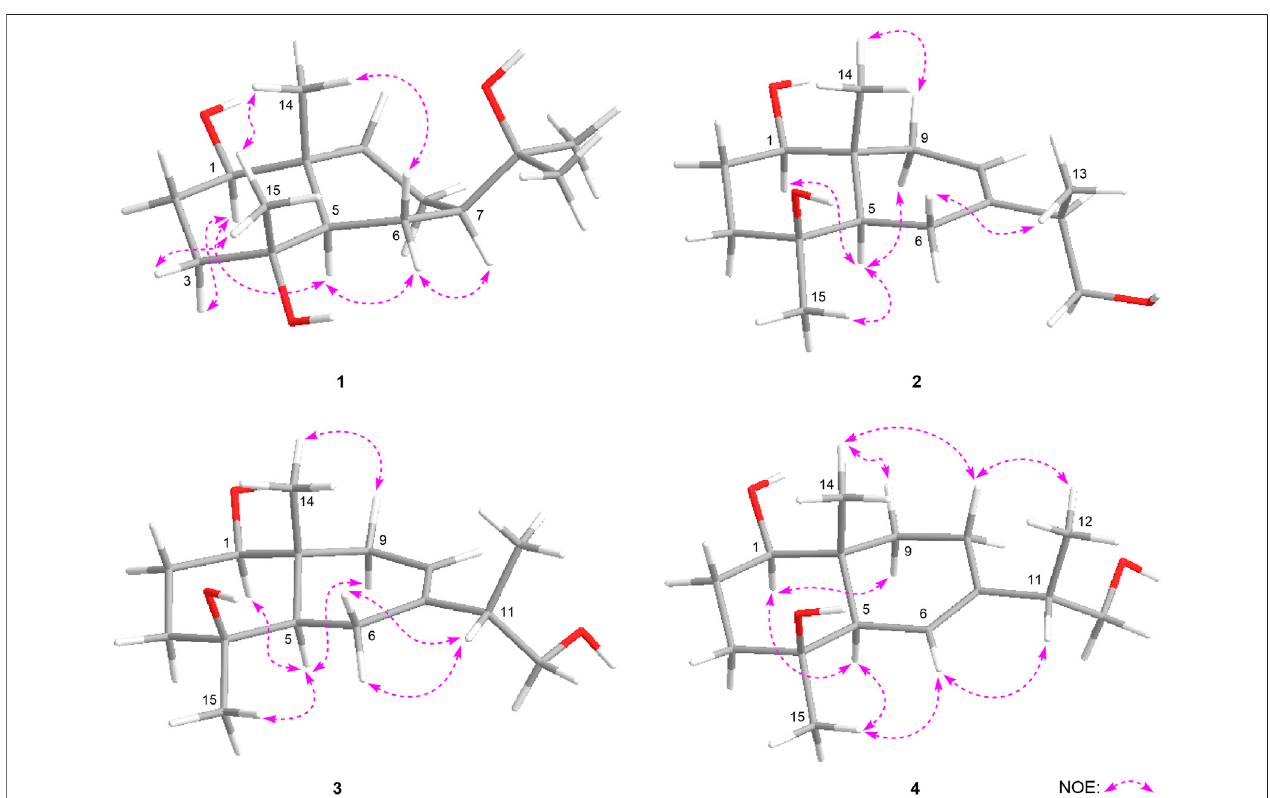
FIGURE 4 | The main NOE correlations of the aglycons of 1 – 4